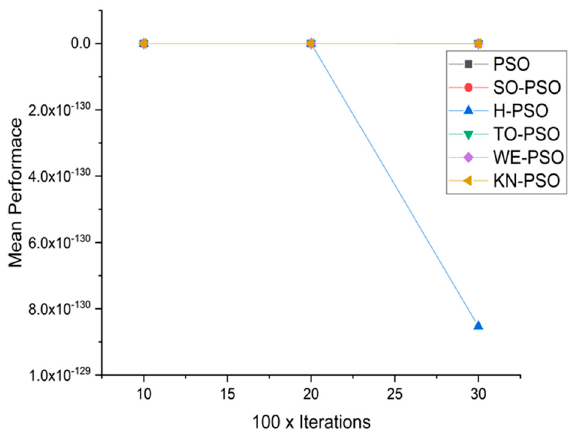
Figure 10. Convergence curve on fn4.